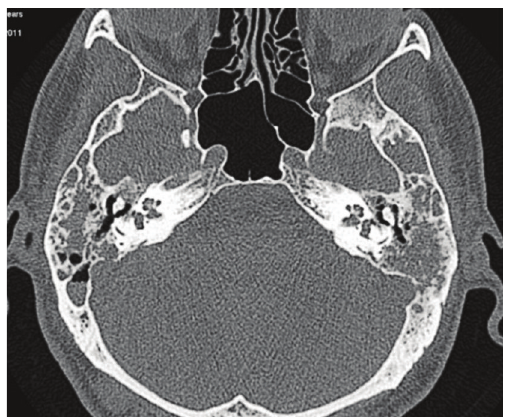
Figure 1: Preoperatively there is fluid intensity in the tympanic cavity and mastoid air cells. Note the irregularity in the bone covering the sigmoid sinus.